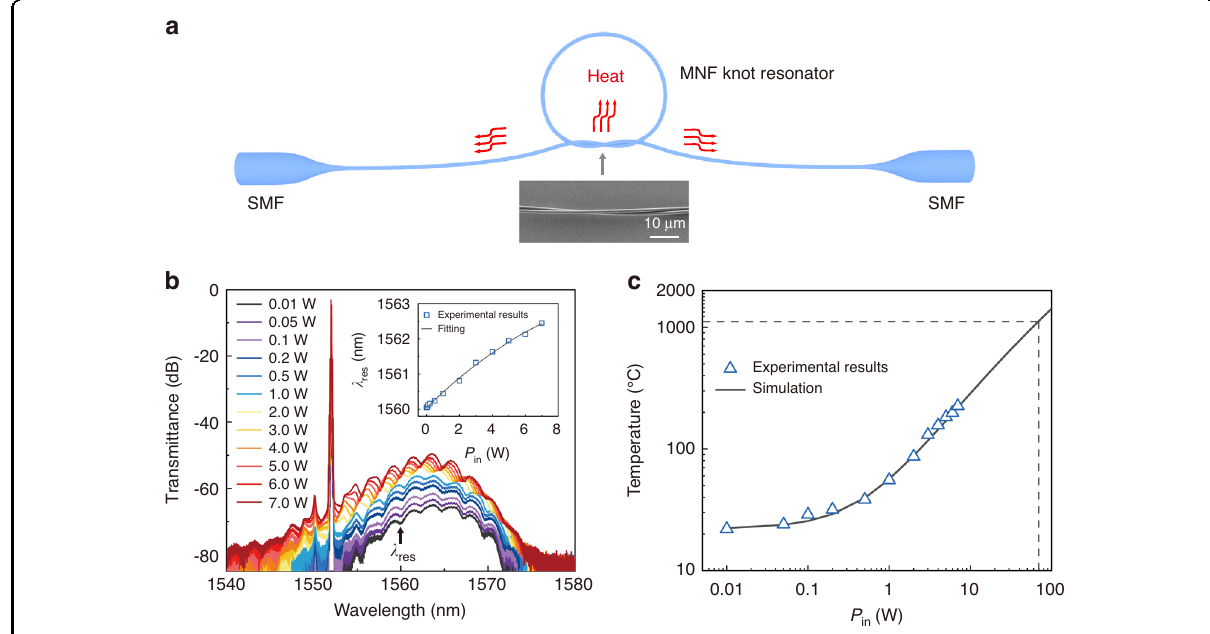
Fig. 2 Optical damage threshold of a MNF around 1550-nm wavelength. a Schematic diagram of a silica MNF knot resonator for measuring temperature rise in the MNF. Inset, scanning electron microscope image of the intertwisted area of the knot employed, which is ∼ 230 µm in diameter and is assembled using a 1.2-µm-diameter MNF. b Transmission spectra of the knot with waveguided power increasing from 0.01 W to 7.0 W. Inset, power-dependent spectral shift of the resonance peak at λ res marked by an arrow. c Measured (blue triangle) and calculated (black line) power- dependent temperature of the MNF, with an extrapolated damage threshold of ~70 W at a temperature of 1100